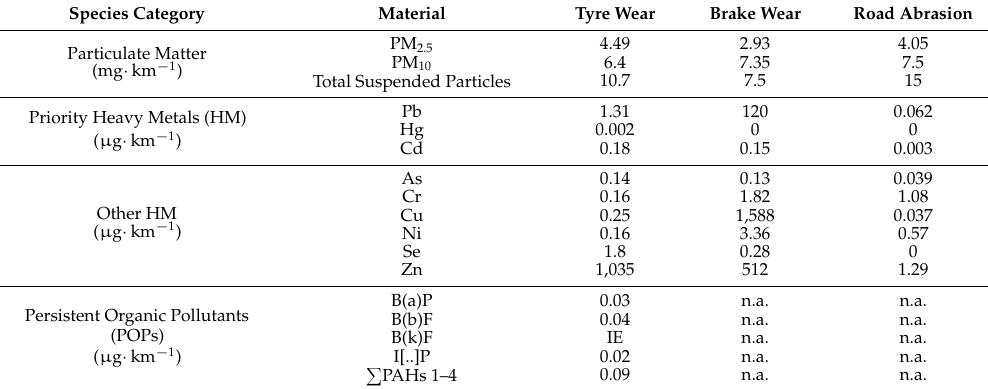
Table 7. Non-exhaust emission inventory